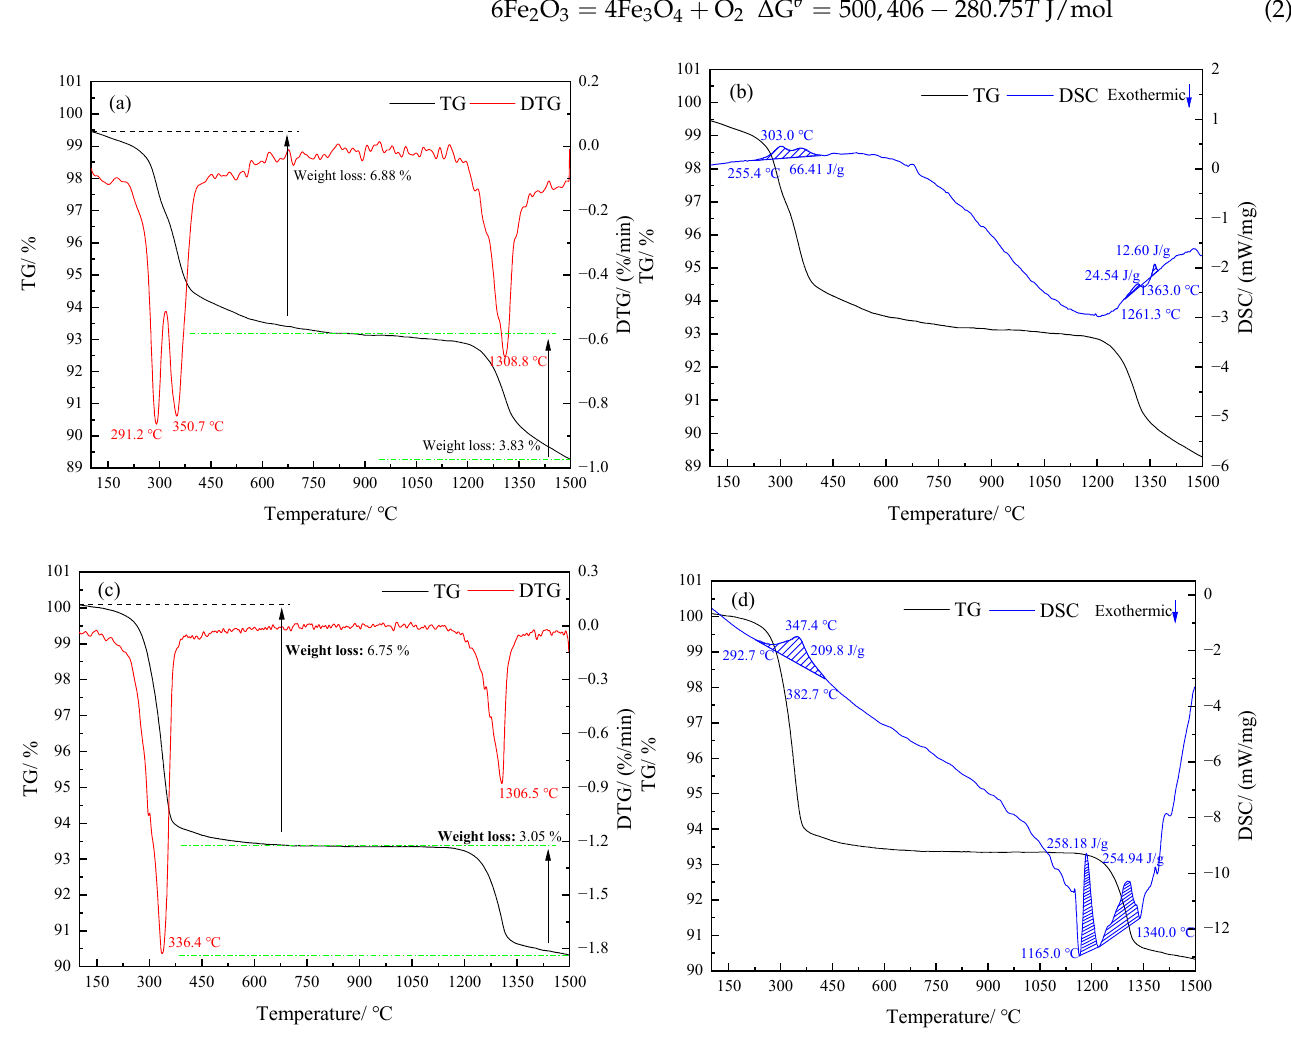
Figure 3. The TG/DSC analysis of #1 and #2 iron ore. ( a ) TG-DTG of #1; ( b ) TG-DSC of #1; ( c ) TG-DTG of #2; ( d ) TG-DSC of #2.